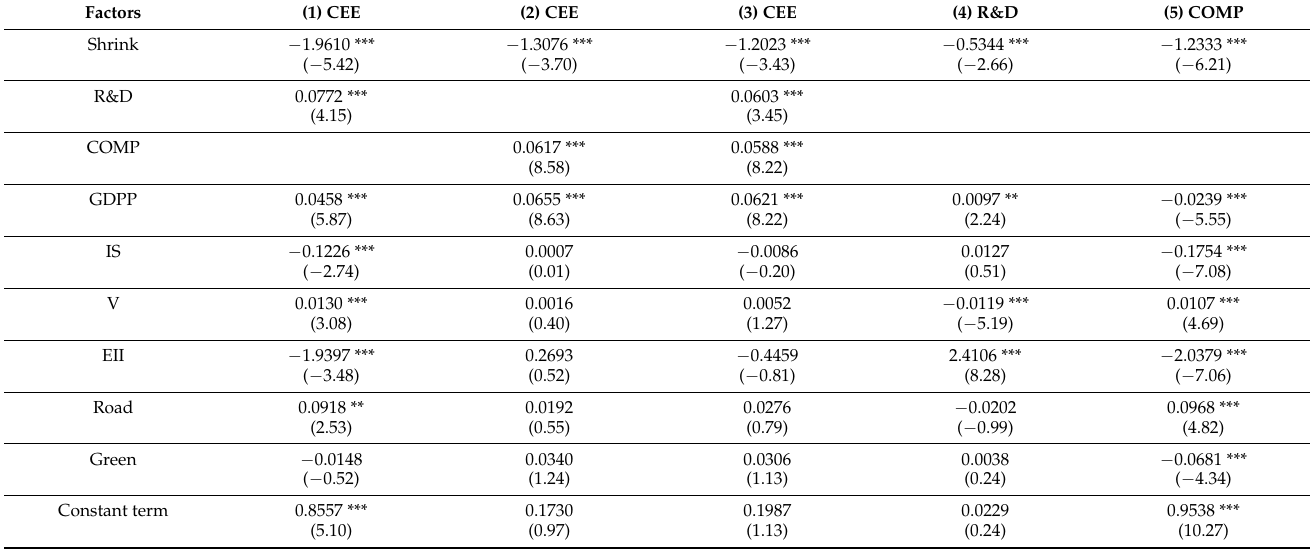
Table 5. Mediating effects